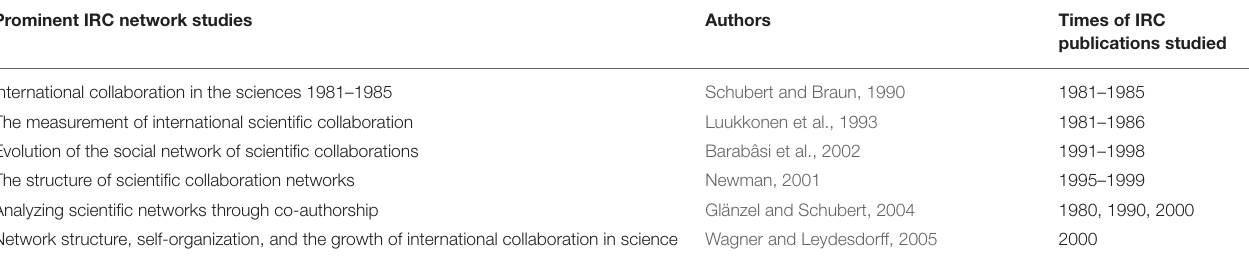
TABLE 1 | The times of IRC publications under survey in prominent IRC network